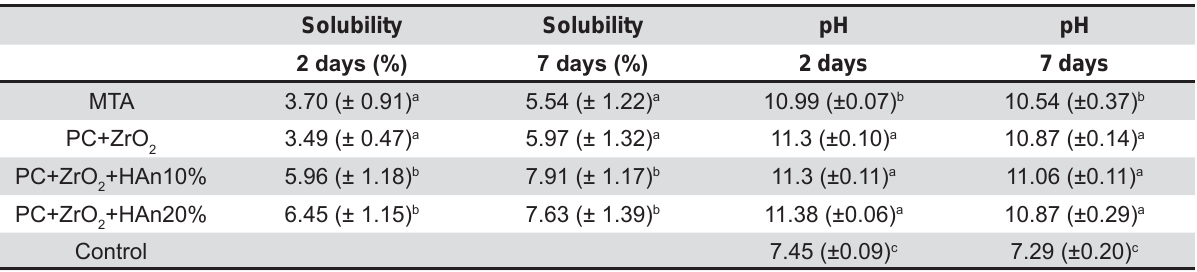
Table 2- Mean values (%) and standard deviation for solubility and pH evaluation (2- and 7-day setting), after 15 hours of